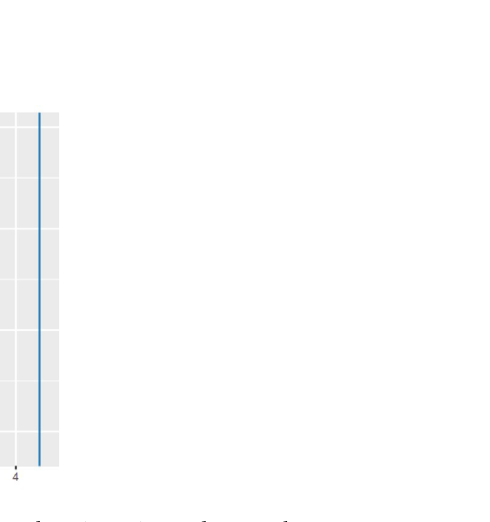
Fig 13. Funnel plot of weight as the exposure, against polycystic ovarian syndrome as the outcome.